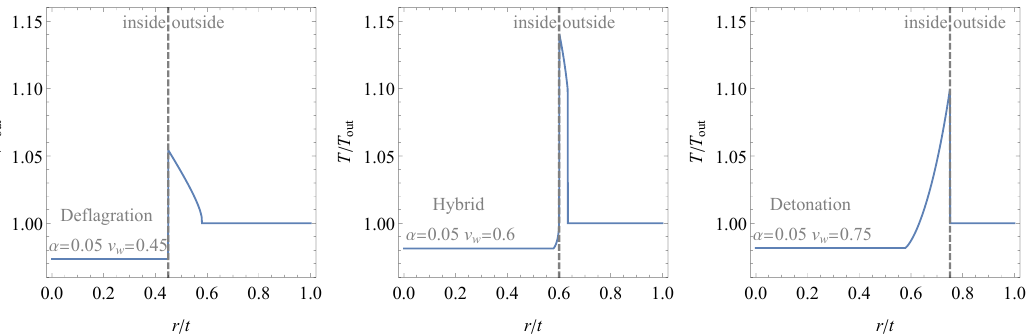
Figure 1 . Temperature variation across the bubble wall for a transition with fixed strength α = 0 . 05 . The three panels correspond to v of solution corresponding to a deflagration, a hybrid and a detonation.